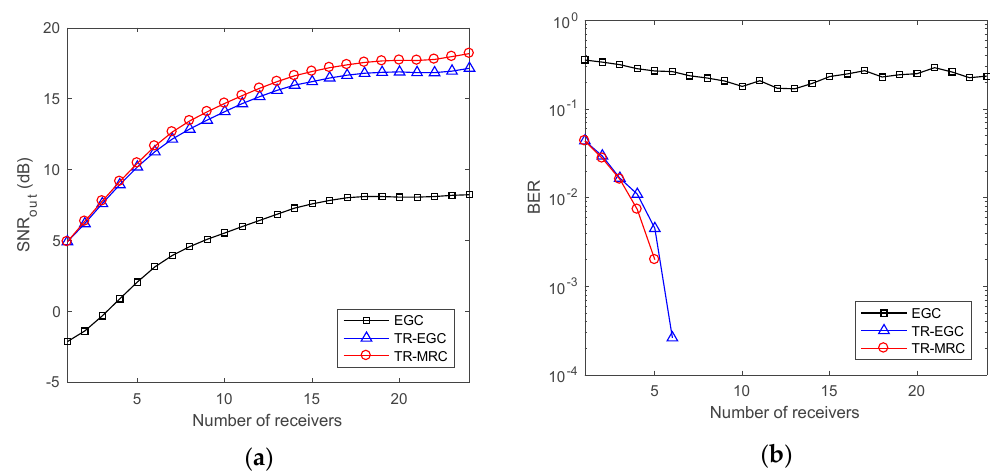
Figure 7. Performance of 50 km UWA communication as a function of the number of receivers. ( a ) Output SNR; ( b ) BER.